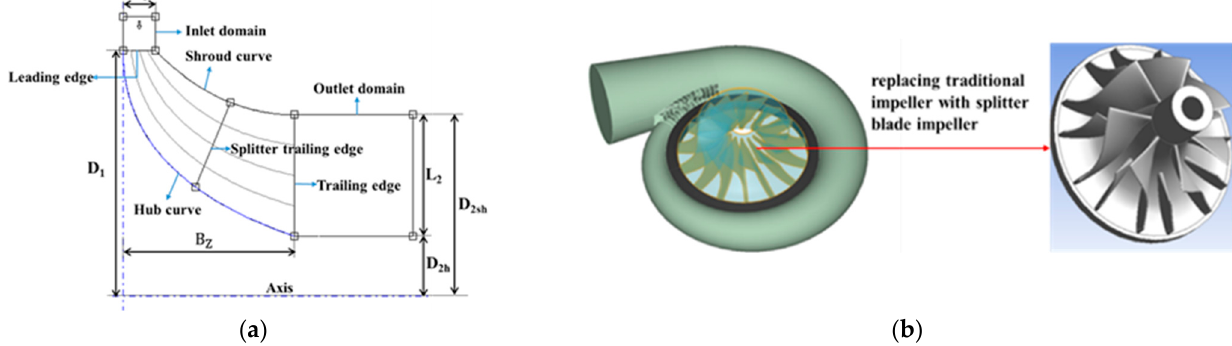
Figure 2. Geometric modeling of impeller: ( a ) Meridian plane of the impeller; ( b ) 3D modeling of turbine and